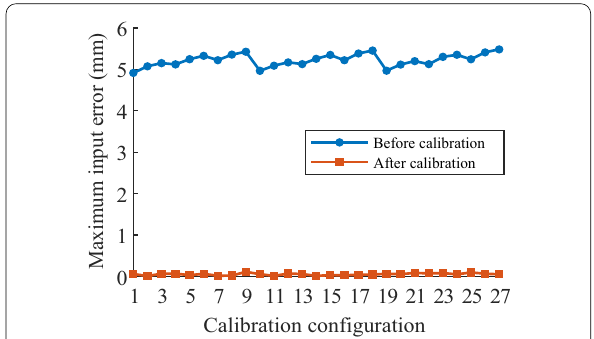
Table 2 Kinematic parameters of the parallel manipulator (mm) Figure 12 Maximum joint coordinate errors of Leg 1 for different calibration configurations